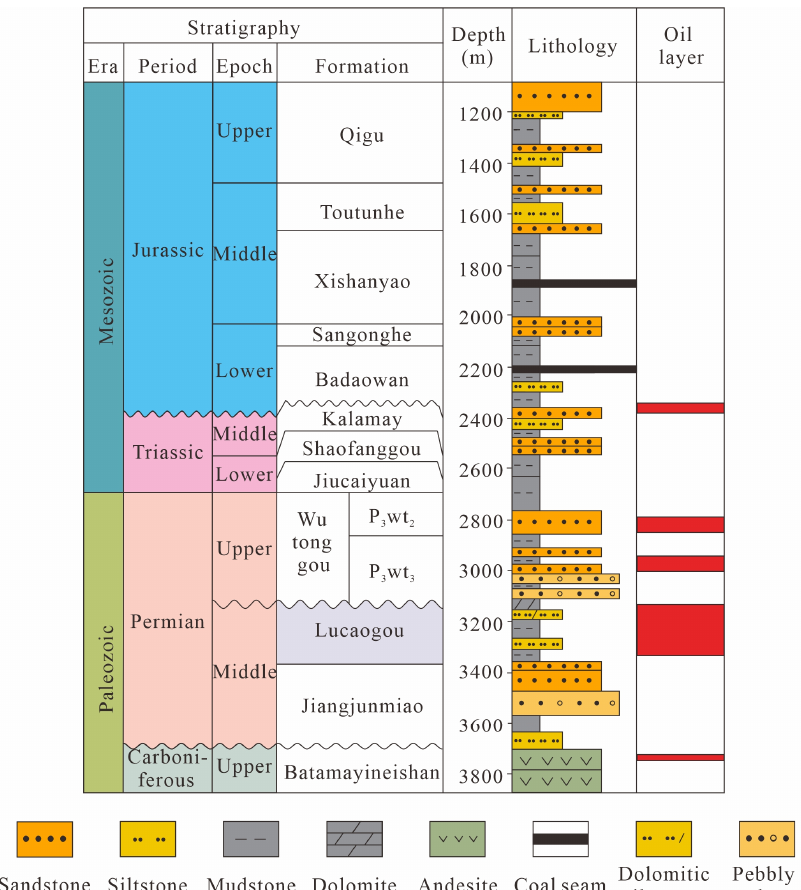
Figure 2. Development characteristics of the Lucaogou Formation and its upper and lower strata in the Jimsar Sag [42].